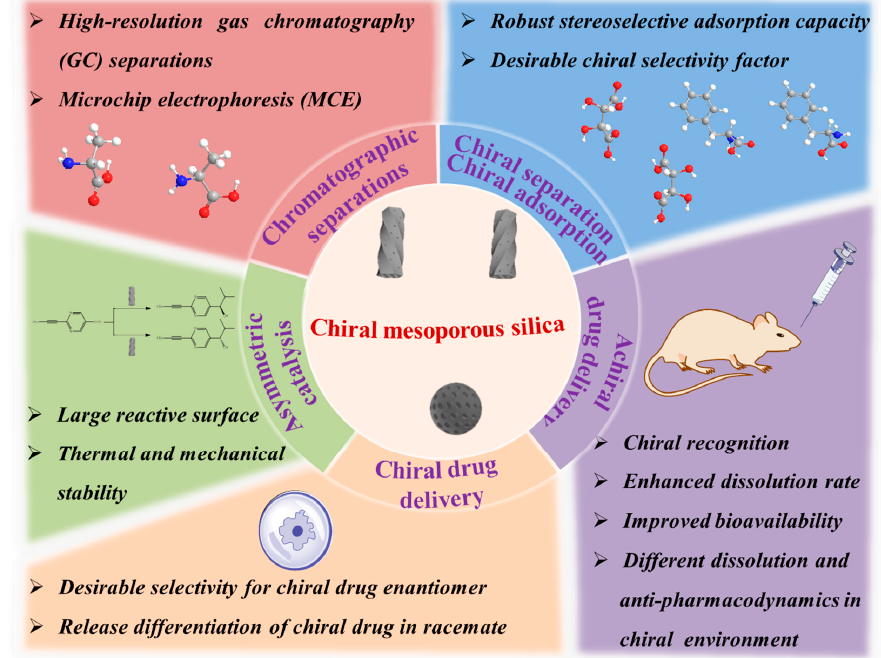
Figure 7. Various applications of CMS. Credit: original figure.